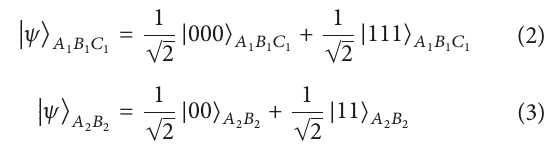
where 𝑖 1 and 𝑖 2 are used to represent particles of two unknown states to be transmitted; factors 𝑎 𝑖 (𝑖 = 0, 1, 2, 3) satisfy